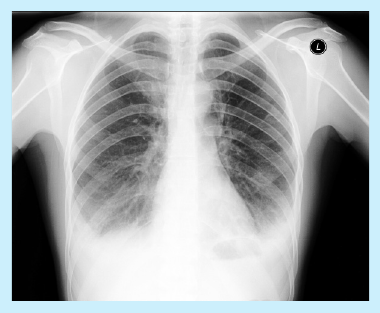
Fig. 1. Bibasal infiltrate with blunting of the costophrenic angles suggesting